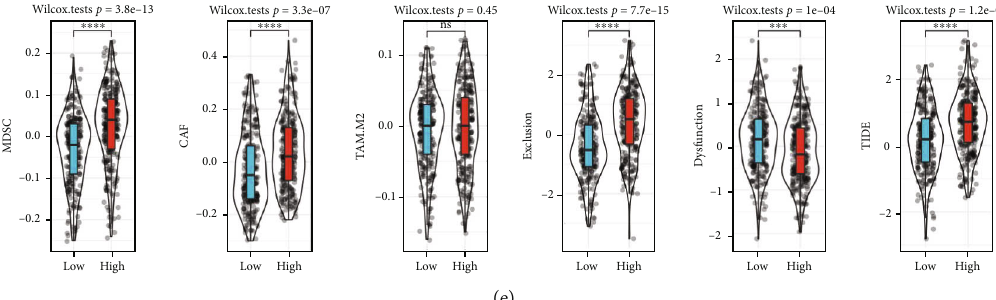
Figure 6: Immune characteristics between two risk groups in the TCGA cohort. (a) The quantity of 22 immune cells analyzed by CIBERSORT. (b) The TCGA cohort immune score and stromal score evaluated by ESTIMATE software. (c) Correlation analysis on CSRS. Score and 22 immune cells in the TCGA cohort. (d) The level of immune checkpoint genes in two risk groups. (e) TIDE analysis for predicting immune response to immune checkpoint blockade. ns: no signi fi cance. ∗∗∗∗ P < 0 : 0001 , ∗∗∗ P < 0 : 001 , ∗∗ P < 0 : 01 , and ∗ P < 0 : 05